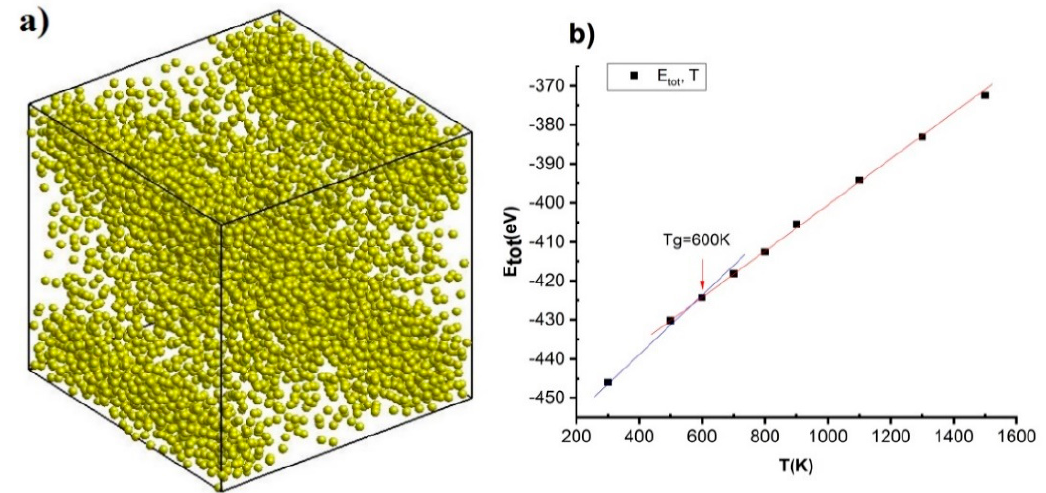
Figure 7. The structural shape of NiAu 5324 alloy at temperatures 700 K ( a ), phase transition ( b ) of NiAu 5324 alloy at different temperatures.